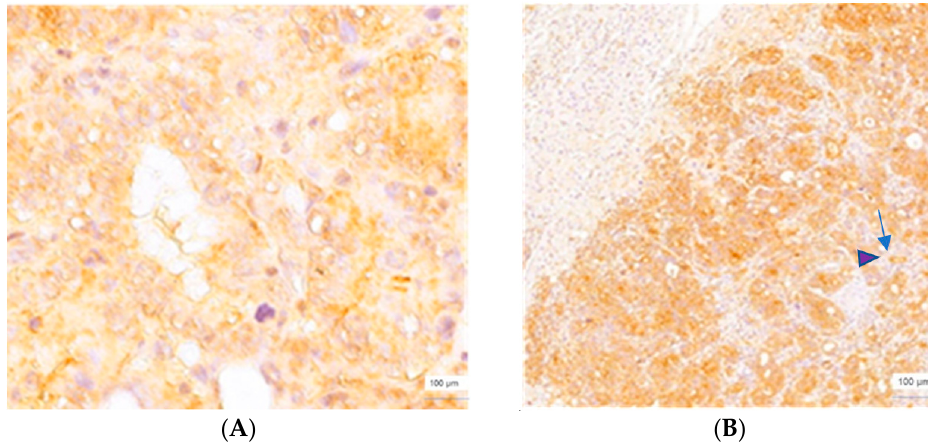
Figure 4. CLIC1 immunoexpression, gastric adenocarcinoma, score of 2, ×400 magnification ( A ), and corresponding LM, pushing HGP, score of 3, ×200 magnification ( B ). CLIC1 expression intensity in the cytoplasm (purple arrow ) increased in the nucleus (blue arrow ) of the cell.